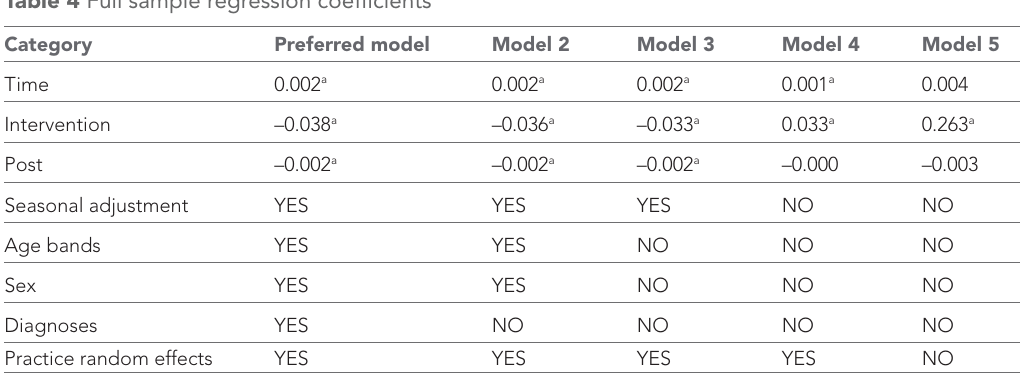
Table 4 Full sample regression